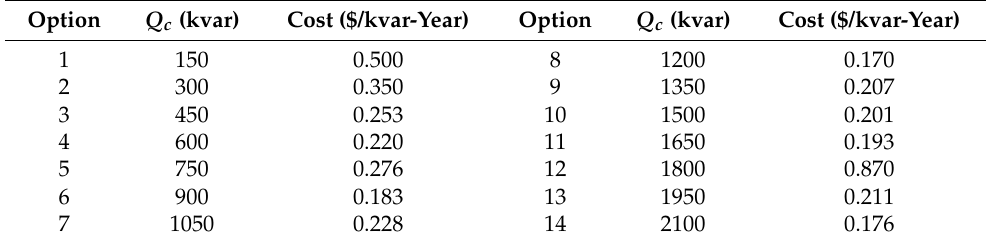
Table 5. Capacitor options and costs per